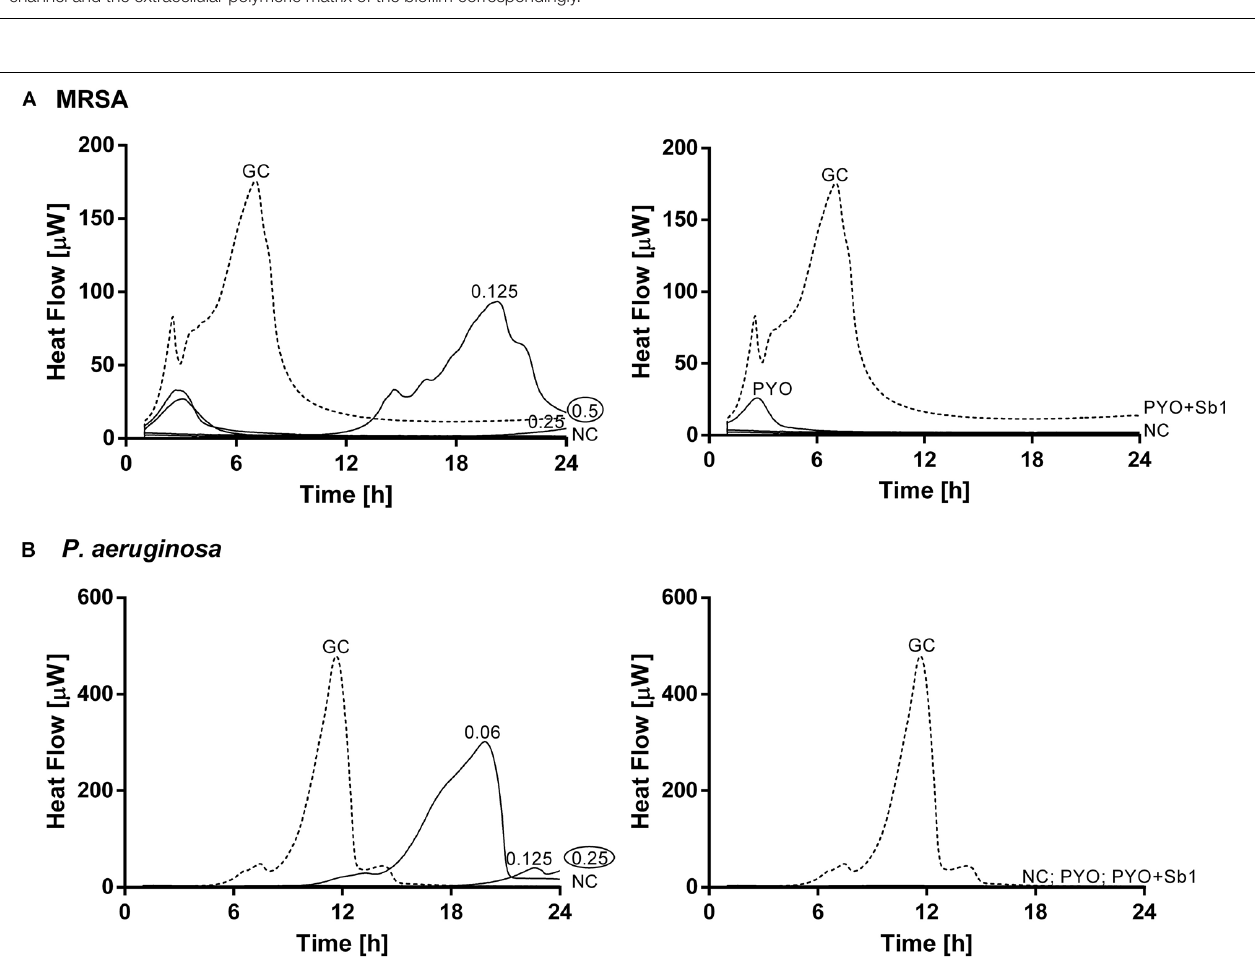
FIGURE 3 | Microcalorimetry analysis of planktonic MRSA ATCC 43300 (A) and P. aeruginosa ATCC 27853 (B) cells treated with two-fold increasing concentrations of ciprofloxacin (left column, numbers represent concentrations in mg/L of antibiotic) or with phages (right column). A circled value represents the MHIC, defined as the lowest concentration of antimicrobial able to suppress the metabolic heat production of planktonic bacteria. GC, growth control (dashed line); NC, negative control. Data of a representative experiment are reported.